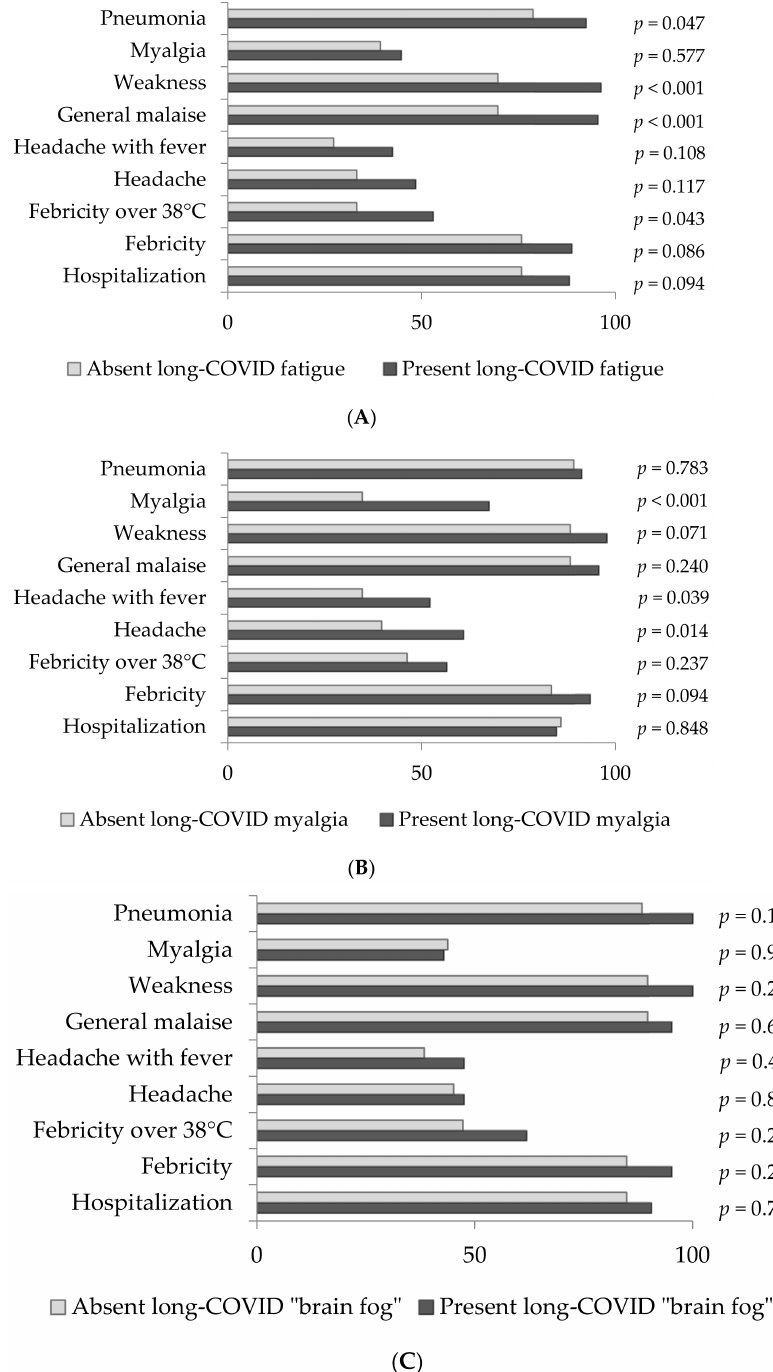
Figure 1. ( A ) The frequency of acute COVID-19 manifestations in population of patients without and with long- COVID fatigue. ( B ) The frequency of acute COVID-19 manifestations in population of patients without and with long-COVID myalgia. ( C ) The frequency of acute COVID-19 manifestations in population of patients without and with long-COVID “brain